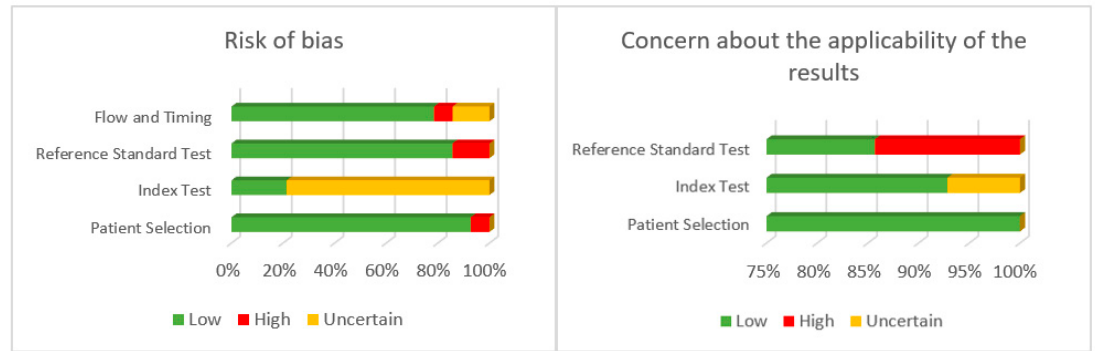
Figure 3. Risk of bias of the articles analyzed.